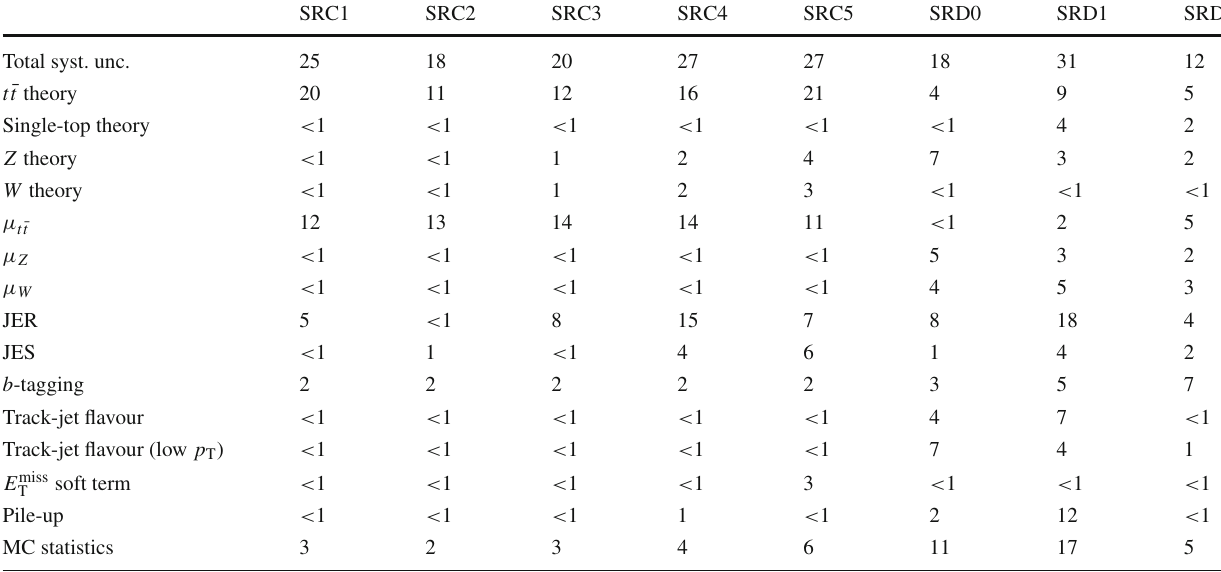
Table 10 Systematic uncertainties (in percent) greater than 1% for at cated for each background component by μ t ¯ t , μ Z , and μ W . The theory least one category within SRC and SRD. Uncertainties are expressed uncertainties quoted for each background include the different distribu- relative to the total background estimates. The uncertainties due to the tion shape uncertainties described in the text scaling of background events based on data in control regions are indi- SRC1 SRC2 SRC3 SRC4 SRC5 SRD0 SRD1 SRD2 Total syst. unc.